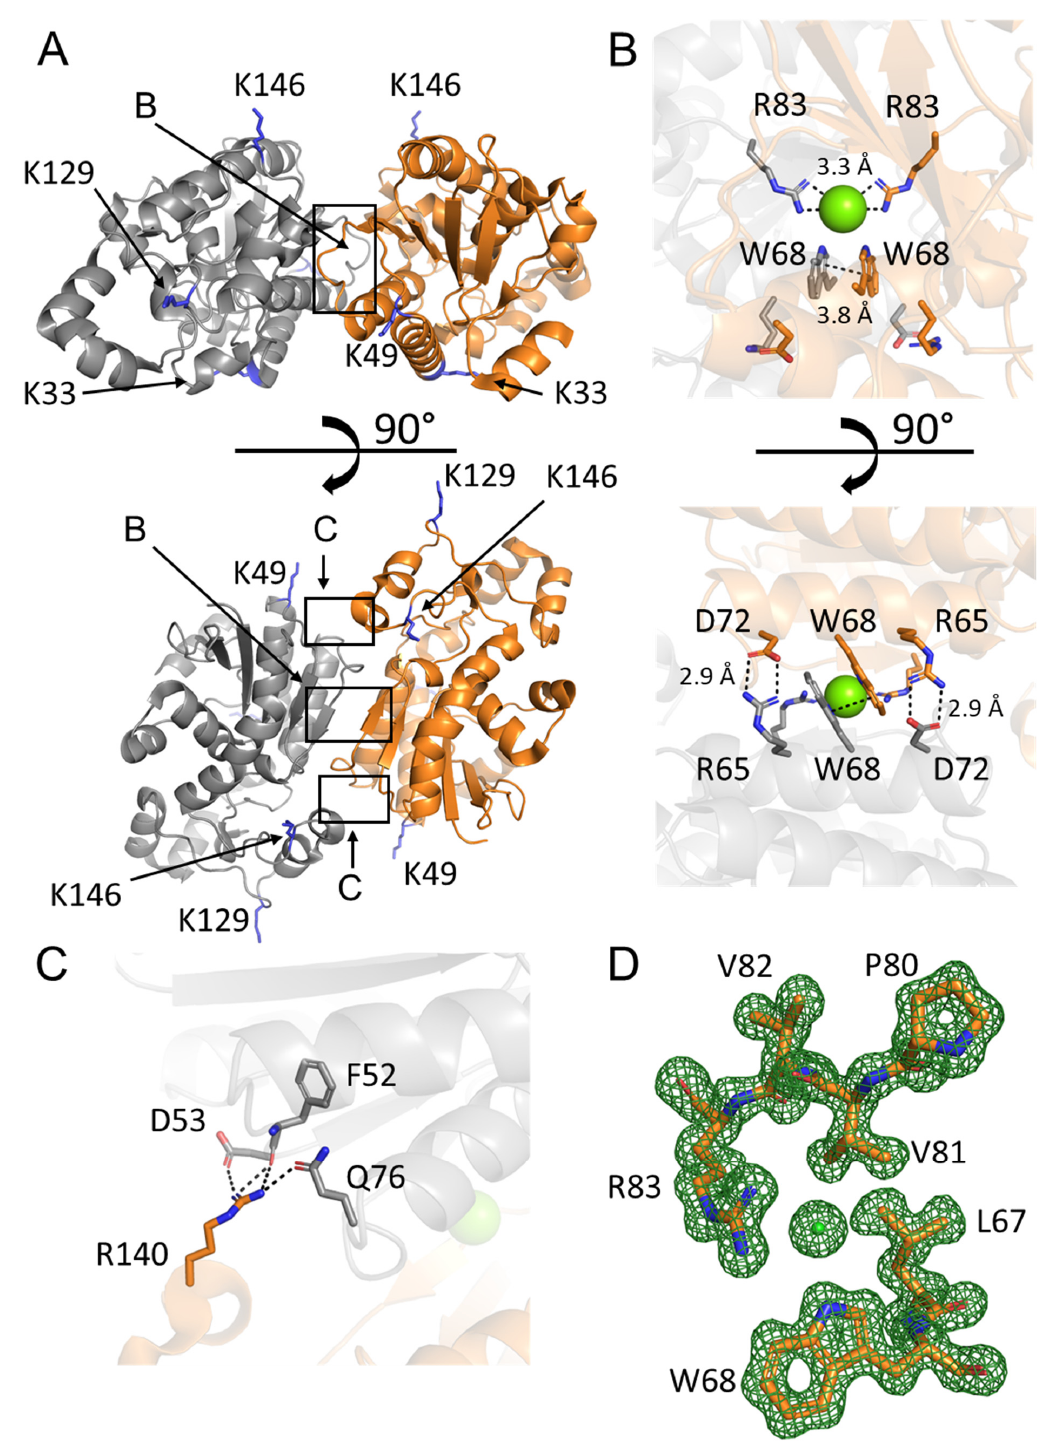
Figure 1. Structure of rabbit muscle PGAM2. ( A ) Overview of the PGAM2 structure: location of close-up views is indicated with labeled arrows; orange, gray—subunits of the PGAM2 homodimer, blue—surface exposed positively charged residues present in PGAM2 but not in PGAM1 (K33, K49, K129, K146). ( B ) Interactions in the central hydrophobic region 60–83; green—chloride ion. ( C ) Interactions at the edge of subunit interface. ( D ) Omit Fo-Fc electron density map of the residues surrounding the chloride ion at the subunit interface, rendered at 3 σ